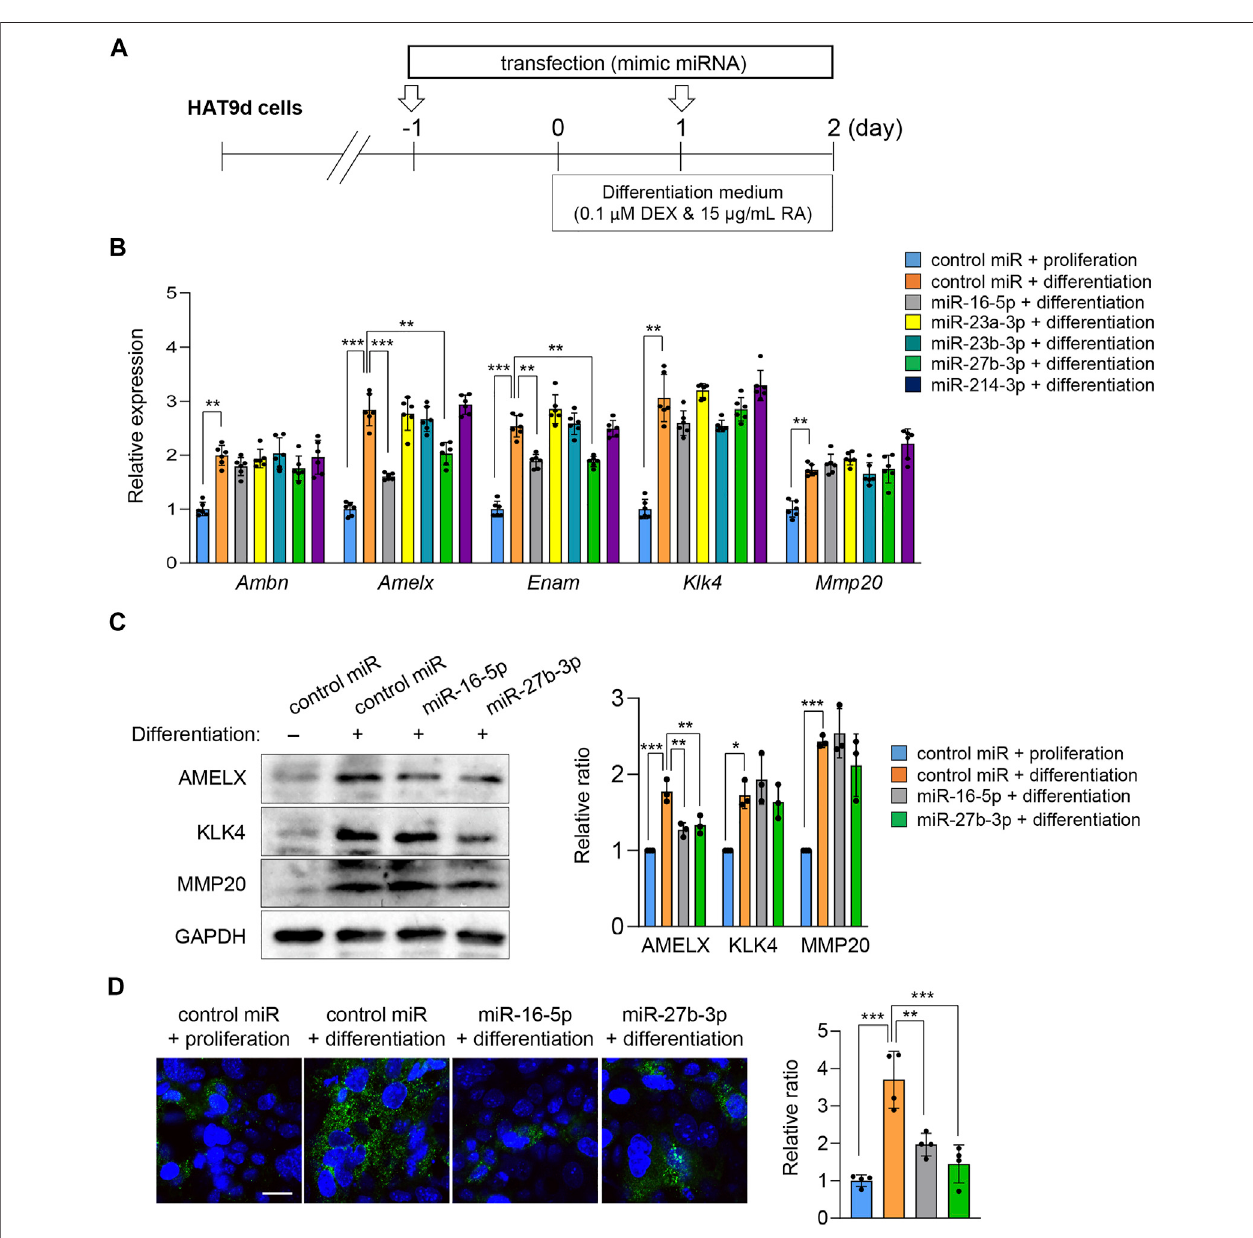
FIGURE 4 | Effects of overexpression of candidate miRNAs asssociated with amelogenesis imperfecta on ameloblast differentiation. (A) Schematic of the experiment. (B) Gene expression of the indicated genes after treatment with the mimic for the indicated miRNA in mHAT9d cells ( n = 6). ** p < 0.01; *** p < 0.001. (C) Immunoblotting for AMELX, KLK4, MMP20, and GAPDH (internal control) in mHAT9d cells under the indicated conditions. Graph shows the quanti fi cation of the immunoblotting. n = 3 per group. * p < 0.05; ** p < 0.01; *** p < 0.001. (D) ICC for AMELX in mHAT9d cells under the indicated conditions. Scale bar, 50 μ m. Graph shows the quanti fi cation of images from four independent experiments. ** p < 0.01; *** p <